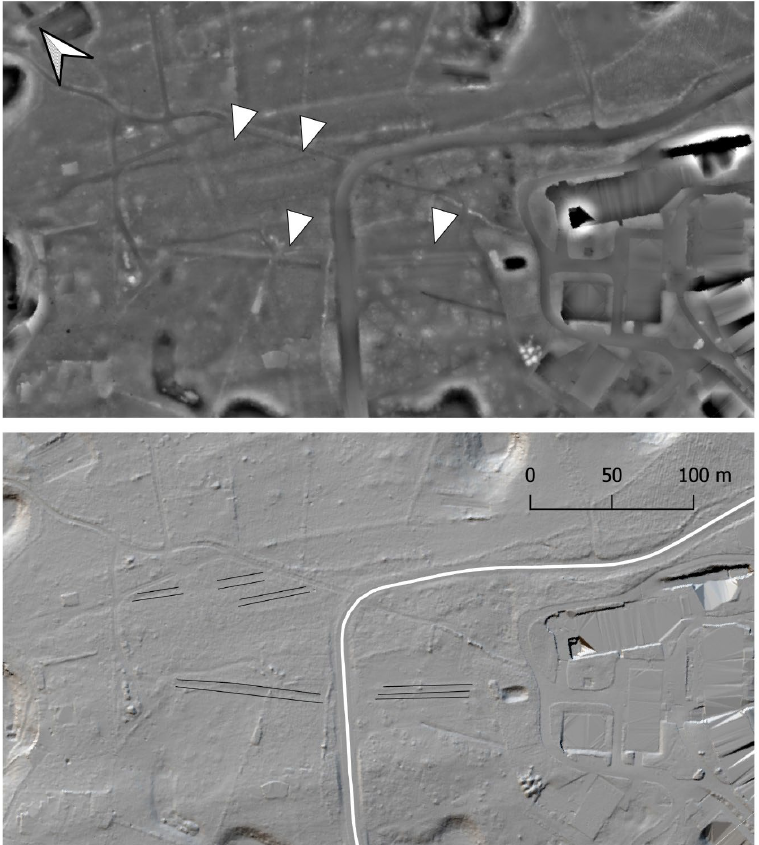
Figure 8. Zoomed view of area C of Figure 2 with the position of road tracks indicated by white arrows in the upper picture (local relief model of an ALS-derived DTM) and by black lines in the lower one (hill-shaded image of an ALS-derived DTM). Modern roads are indicated by white lines. After area C, the traces of the road continue in the same direction for about 1 km (area D; Figure 9) and then turn north (area E; Figure 10), maintaining more or less the same elevation above sea level, until the road skirts the internal base of the Karst coastal ridge continuing in the direction of Prosecco (Figure 1). In this area, the coastal chain of the Karst and the offshoots of the more internal elevations delimit a narrow corridor, about 1 km wide, where searches focused on, allowing me to identify a stretch of the road route (Area F; Figure 11). Interestingly enough, even today the modern road network is concen- trated within this band.